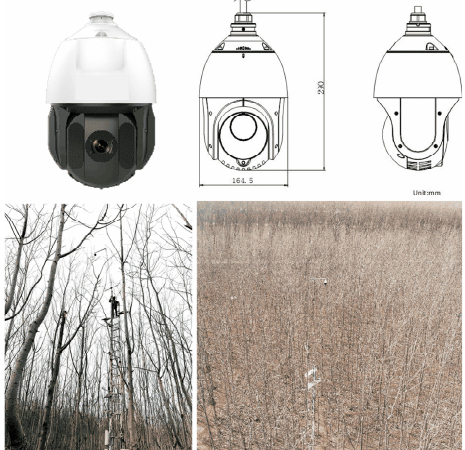
Figure 3. Test equipment and installation